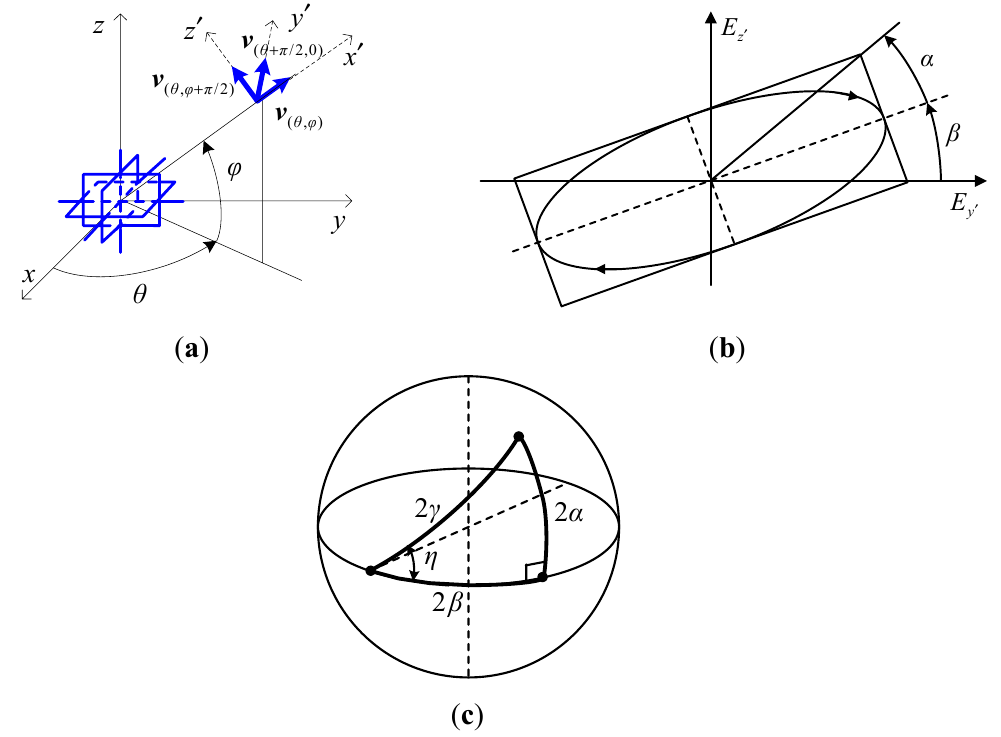
Figure 2. The angle and polarization definitions. ( a ) The angle definition. ( b ) Polarization ellipse. ( c ) Poincare